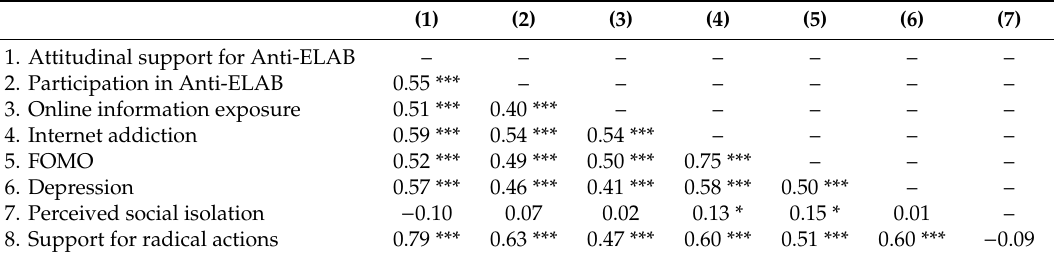
Table 2. Correlations of key